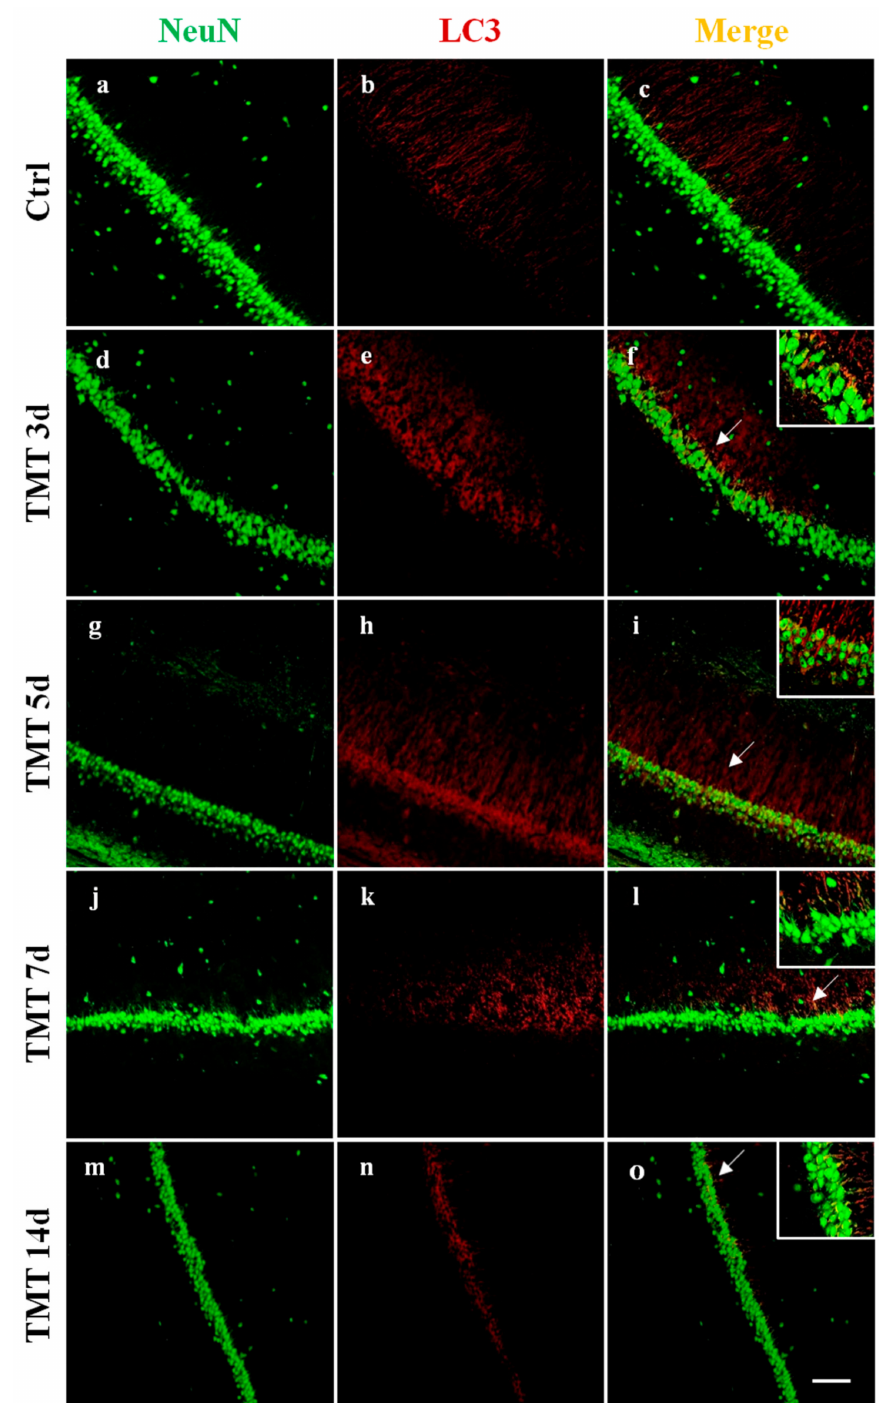
Figure 2. Localization and expression of LC3 in the rat hippocampal neurons, after TMT treatment, in the CA1 area are shown. Sections of the CA1 field at di ff erent post-intoxication time-points (3, 5, 7, and 14 days) are labeled for Neu N (green, a , d , g , j , m ), LC3 (red, b , e , h , k , n ), and Neu N / LC3 (merge, c , f , i , l , o ). Control sections ( a – c ). At 3 days after treatment, marked LC3 immunoreactivity was observed ( e ) and LC3 labeling strongly increased at 5 days ( h ). LC3 staining decreased at 7 ( k ) and 14 days ( n ) post intoxication. Note the progressive loss of Neu N-positive neurons in TMT-treated rats ( d , g , j , m ) compared with control rats ( a ). Arrows and inserts show details. Scale bar: 100 µ m. Ctrl: control sample, d: days. For interpretation of the references to color in this figure legend, the reader is referred to the Web version of this